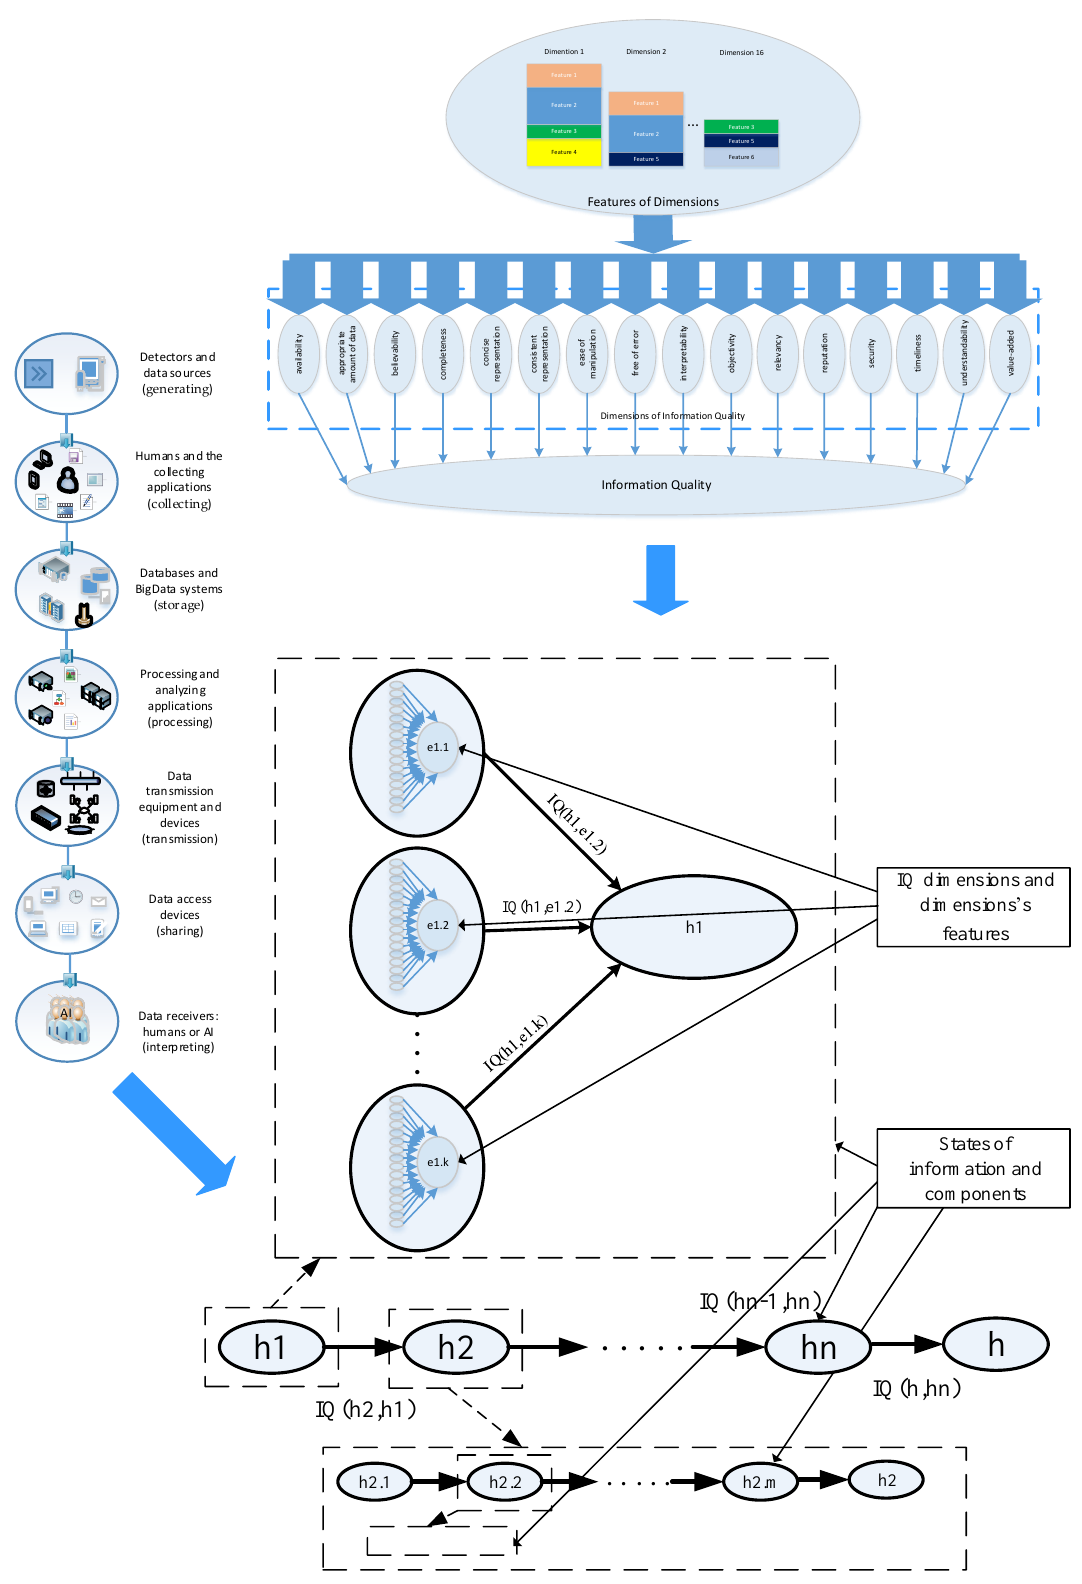
Figure 2. Information quality model layers (the authors’ own study based on [2 – 5]).